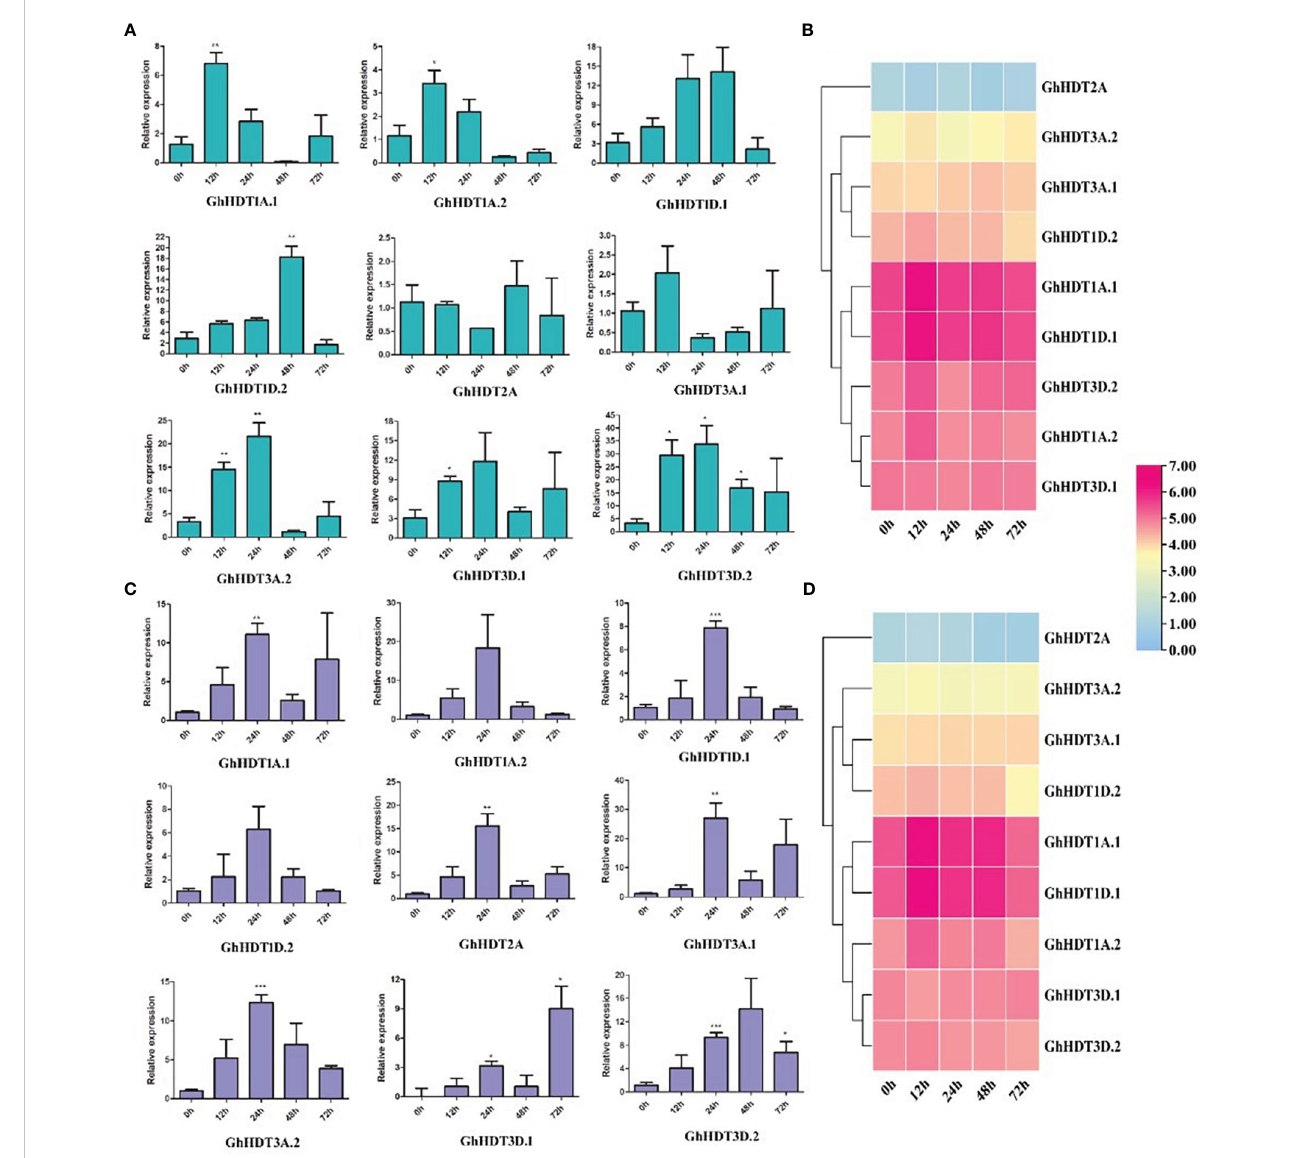
FIGURE 10 The qRT-PCR expression pro fi les of putative HD2 genes in G. hirsutum . Bars represent expression levels at 12, 24, 48, and 72 h of (A) drought (20% PEG solutions PEG8000) and (C) salt (300 MM) stress treatment, as compared to control levels at 0 h. Ubiquitin was taken as a normalizing control. Three replicates were used for each experiment. Two-tailed Student ’ s t-tests were used for statistical analysis; data are plotted in the form mean ± s.d, with error bars representing standard deviations. Signi fi cant differences are denoted with asterisks: *P < 0 0.1; **P < 0 0.01; ***P < 0 0.001. Right panels show expression pro fi les of HD2 genes under (B) drought and (D) salt conditions according to RNA-Seq data, using log2FPKM